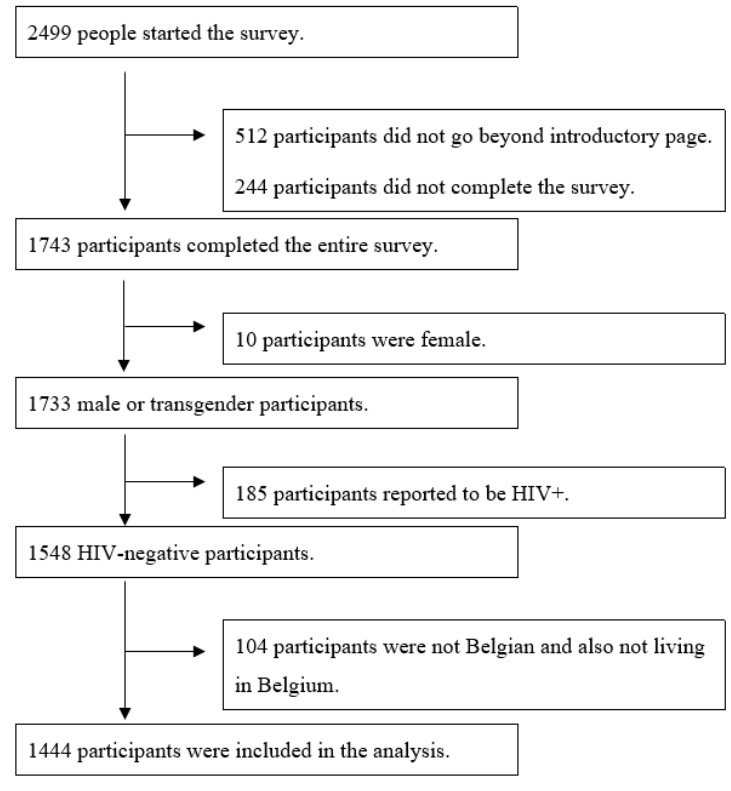
Figure 1. Inclusion criteria for data analysis. Table 1. Socio-demographic characteristics of participants a.